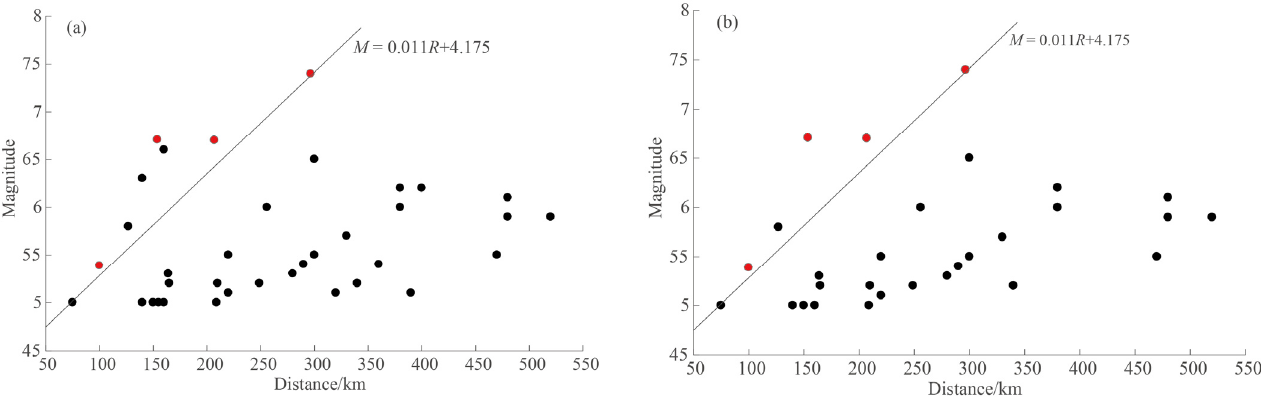
Figure 6. Scatter diagrams of magnitude and epicentral distance for ( a ) 37 and ( b ) 30 earthquakes.